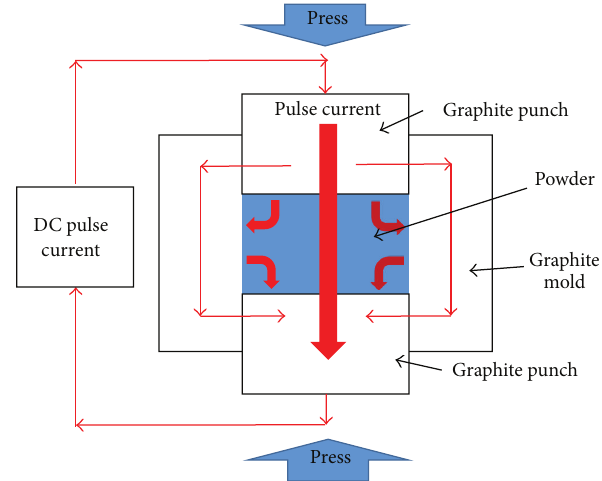
Figure 1: Schematic diagram of the apparatus for spark plasma sintering.